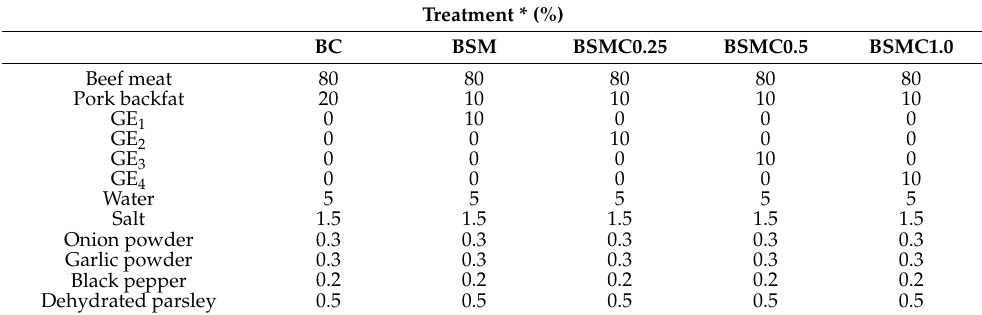
Table 2. Formulation of beef burgers with and without gelled emulsions (GE) of maca, soybean oil, and chincho essential oil used as partial substitutes for animal